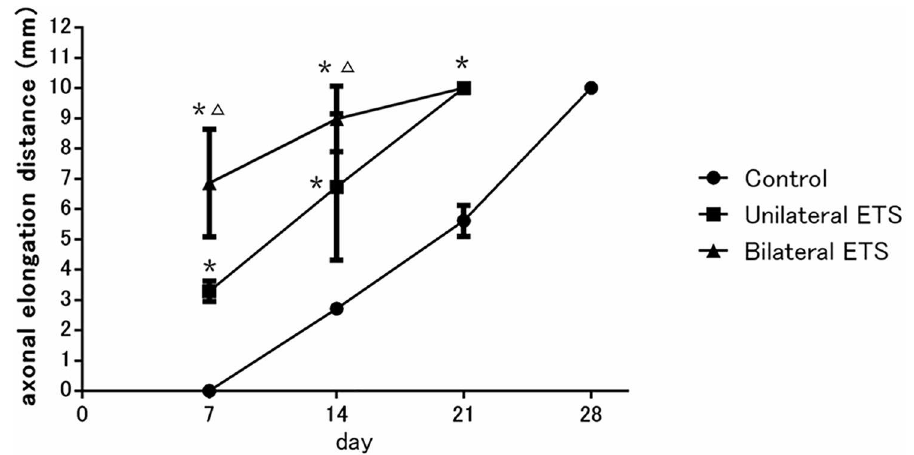
Fig 6. In vivo imaging of axonal elongation in engraftment model. Yellow fluorescent protein-labeled axons enteringthe acellular nerve allograft (ANG) engraftment were measuredevery 7 days (n = 4 per group). In particular, axonal elongationaccelerated in the bilateralend-to-side (ETS) group at 7 days after surgery. Subsequently, axonalelongationproportionately increasedand was achievedat the distal edge of ANG at 21days post transplantationin the unilateraland bilateralETS groups. Differencesbetweenthe ANG containing Schwanncell group and control group were significant. * Significantly different from the control group (p < 0.05); Δ , significantly different from the unilateralETS group (p <